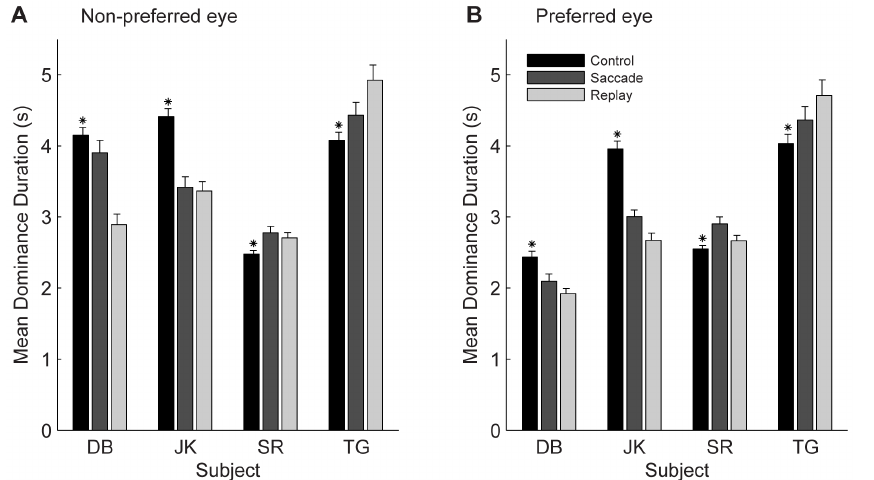
Figure 9. Mean dominance durations. Average dominance durations per subject of the non-preferred (A) and preferred (B) eye under static viewing conditions (black) and in the saccade (dark gray) and replay (light gray) conditions. Error bars indicate 6 1 SEM. Asterisks indicate significant differences between control and (pooled) shift conditions (t-test, p , 0.05).